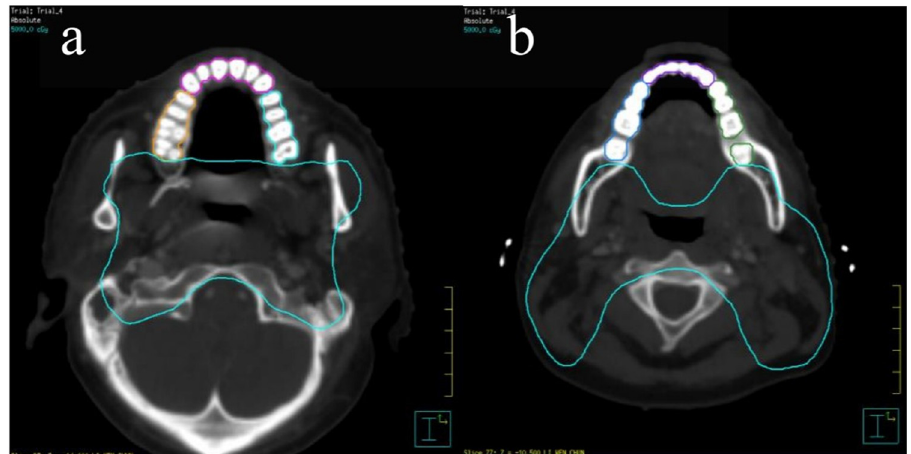
Figure 1: ( a ) Delineation of the maxillary teeth on CT images and ( b ) delineation of the mandibular teeth on CT images ( The dose line is 50 Gy. CT: window: 1,500, level: 800. )